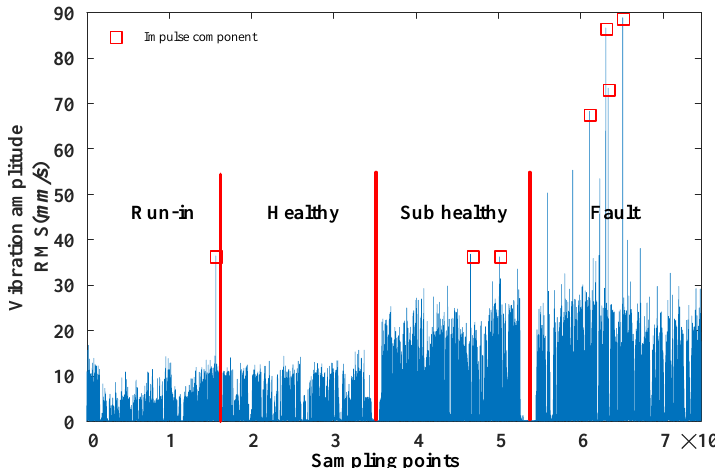
Figure 8. V-direction vibration waveform of the gearbox.